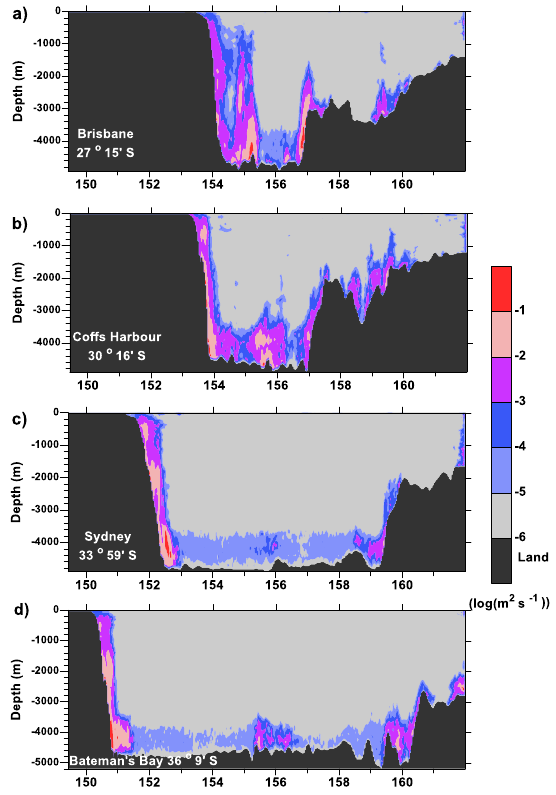
Fig. 14 Log of the difference of the significant vertical temperature diffusivity between the tidal and non-tidal simulations along four latitude transects: a 27° 15’ S off Brisbane, b 30° 16’ S off Coffs Harbour, c 33° 59’ S off Sydney, and a 36° 9’ S off Bateman’s